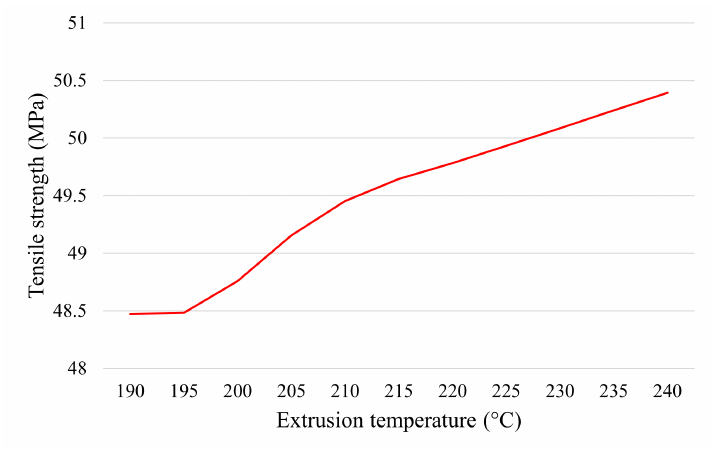
Figure A11. Graphs tensile strength vs. extrusion temperature generated from the algorithm.